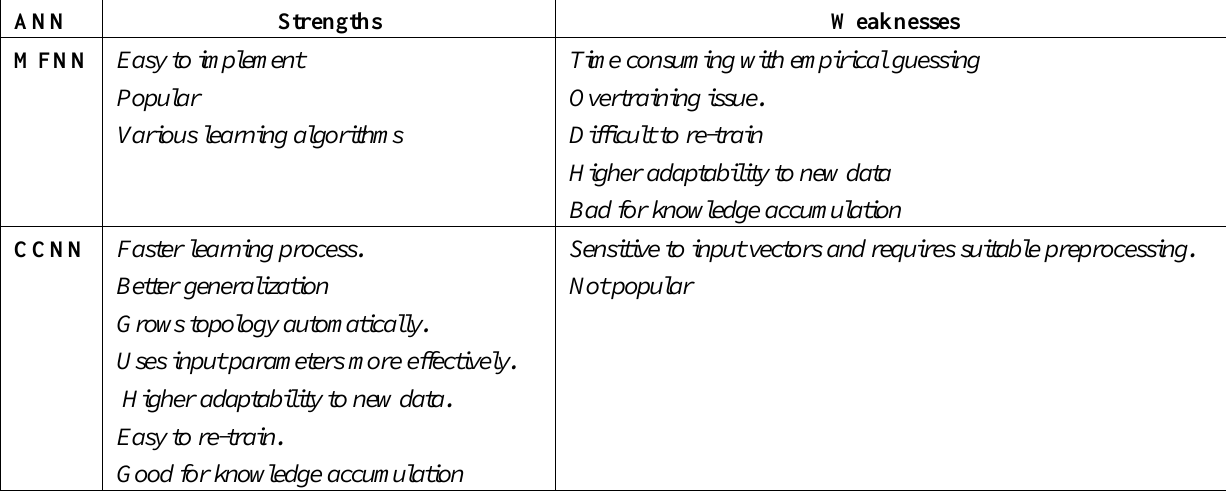
Table 5. The comparison between MFNN and CCNN